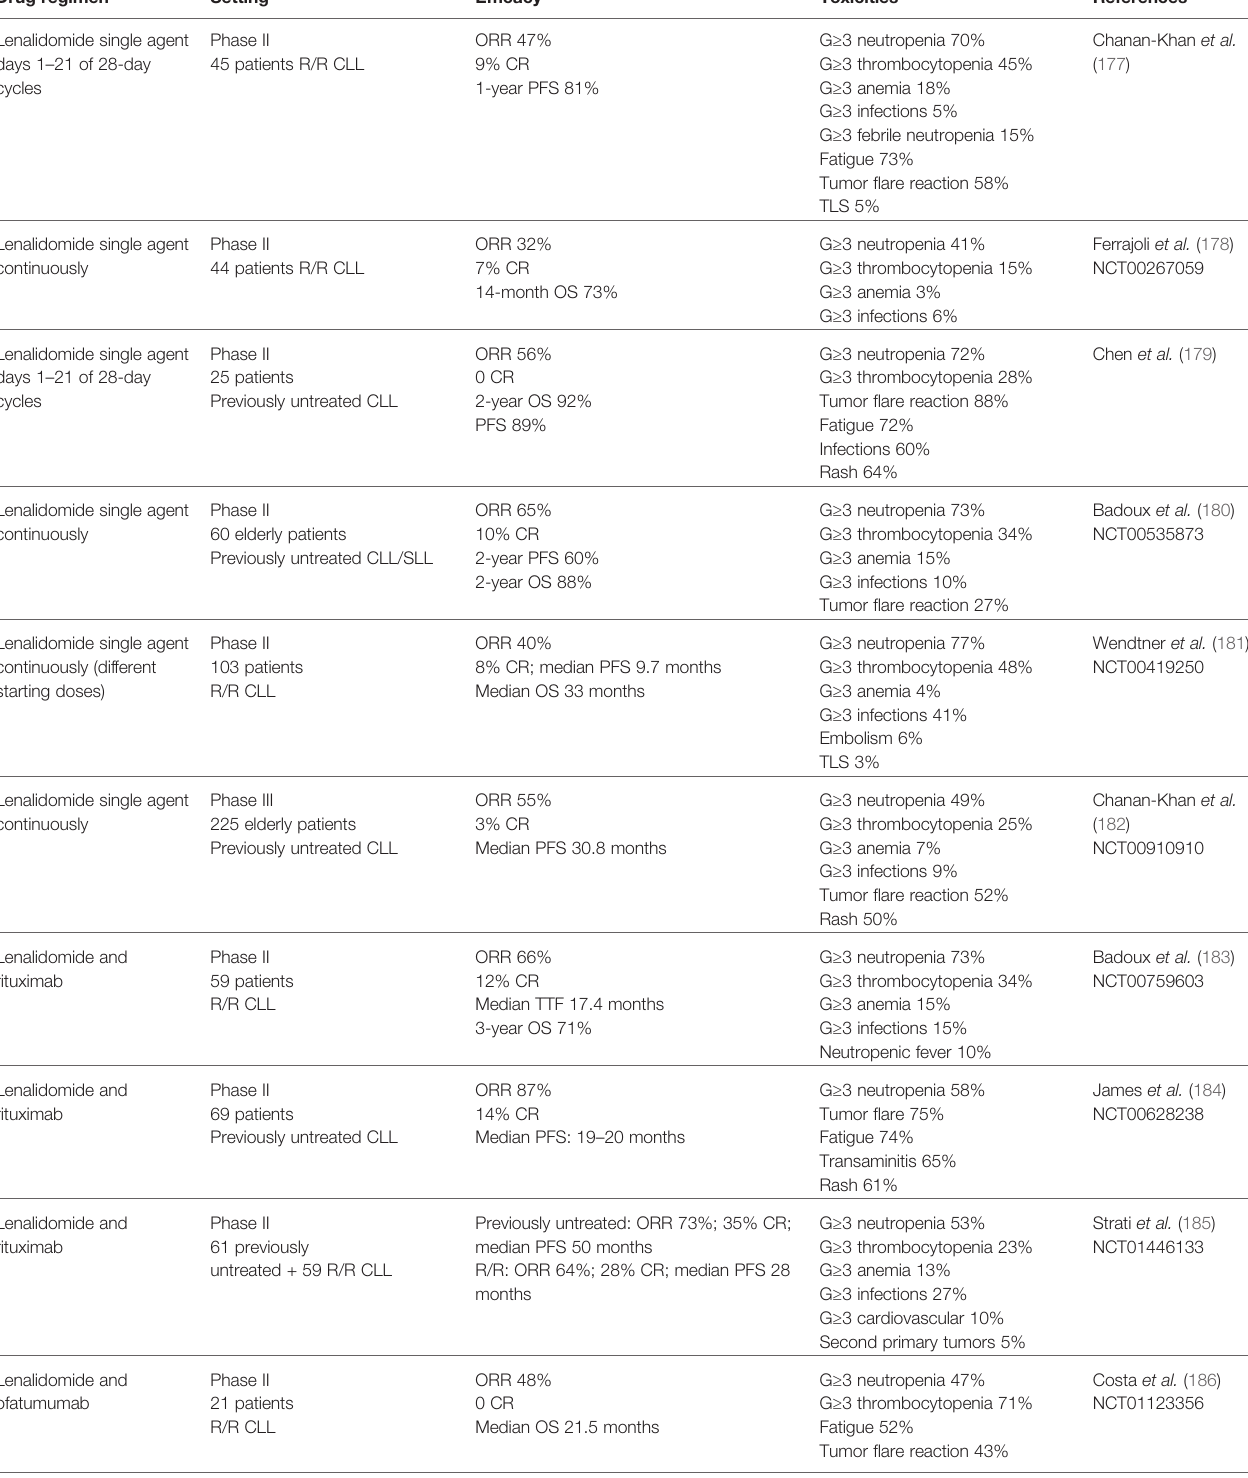
TABLE 1 | Clinical trials evaluating the ef fi cacy and toxicity of lenalidomide, used as a single agent or in combination regimens, for the treatment of patients with CLL. Drug